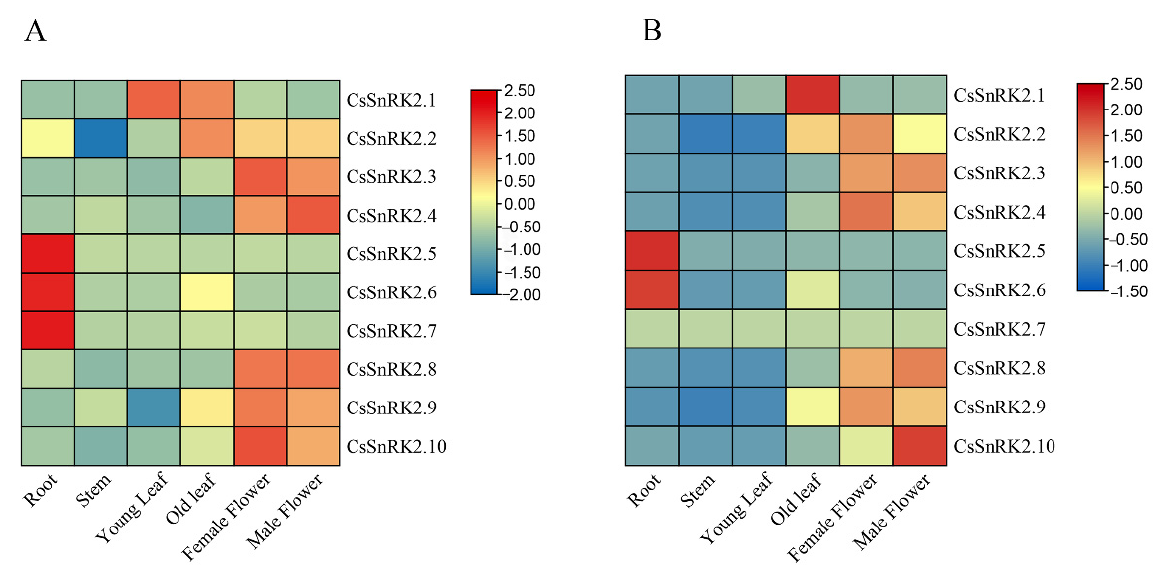
Figure 6. Expression patterns of 10 CsSnRK2 genes in six tissues of cucumber. ( A ) The expression level based on the RNA sequencing data from SRA database of NCBI (accession number SRP071224). ( B ) The relative expression levels of CsSnRK2 genes in different tissues from qRT-PCR analysis. Color bars represent expression values: red and blue indicate high and low expression levels, respectively.